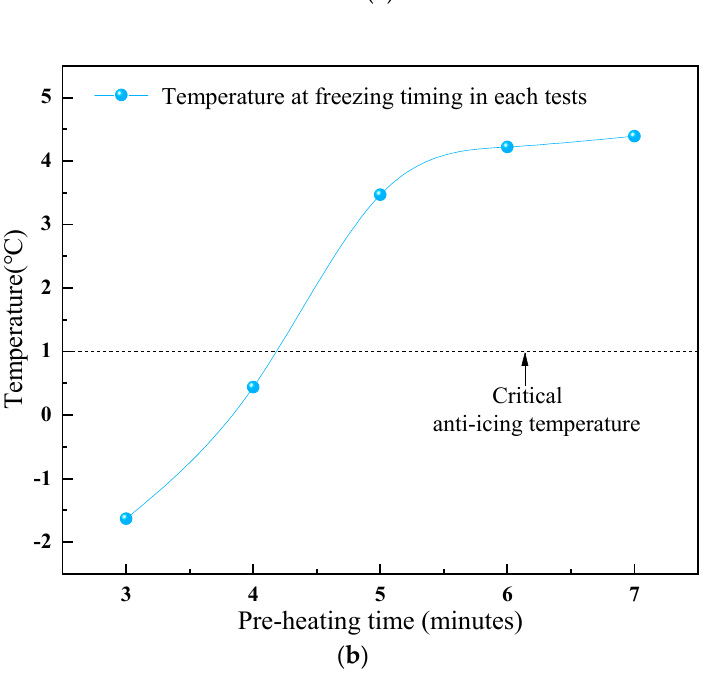
Figure 13. ( a ) Anti-icing effects under different pre-heating times; ( b ) variation of temperature at freezing moment with the pre-heating time. freezing moment with the pre-heating